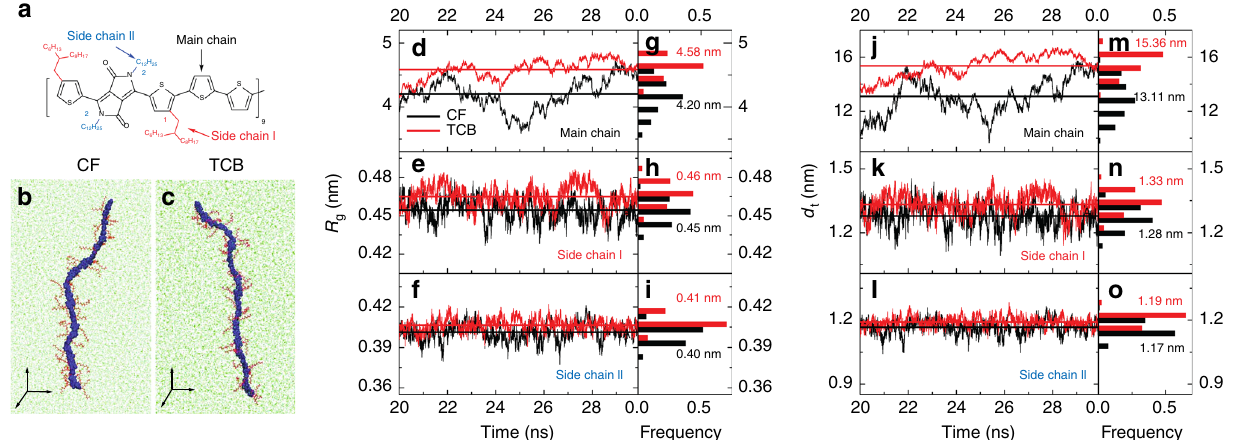
Fig. 3 Molecular dynamics simulations. a Chemical structure for a D-PDPP4T-HD nonamer. b , c Snapshots from trajectories of D-PDPP4T-HD nonamer chains in chloroform (CF) and 1,2,4-trichlorobenzene (TCB). d , e , f , Gyration radius ( R g ) of main chain, side chain I and side chain II in CF (black) and TCB (red). The straight lines indicate the average values of R g . g , h , i , Corresponding distributions of d , e , f . j , k , l , Head-to-tail distance ( d t ) of main chain, side chain I and side chain II in CF (black) and TCB (red). The straight lines indicate the average values of d t . m , n , o , Corresponding distributions of j , k , l . The last 10 ns simulation time after equilibration was selected for sampling. If all chains were straight, the d t of main chain, side chain I and side chain II would be 18.52, 1.62, and 1.41 nm,